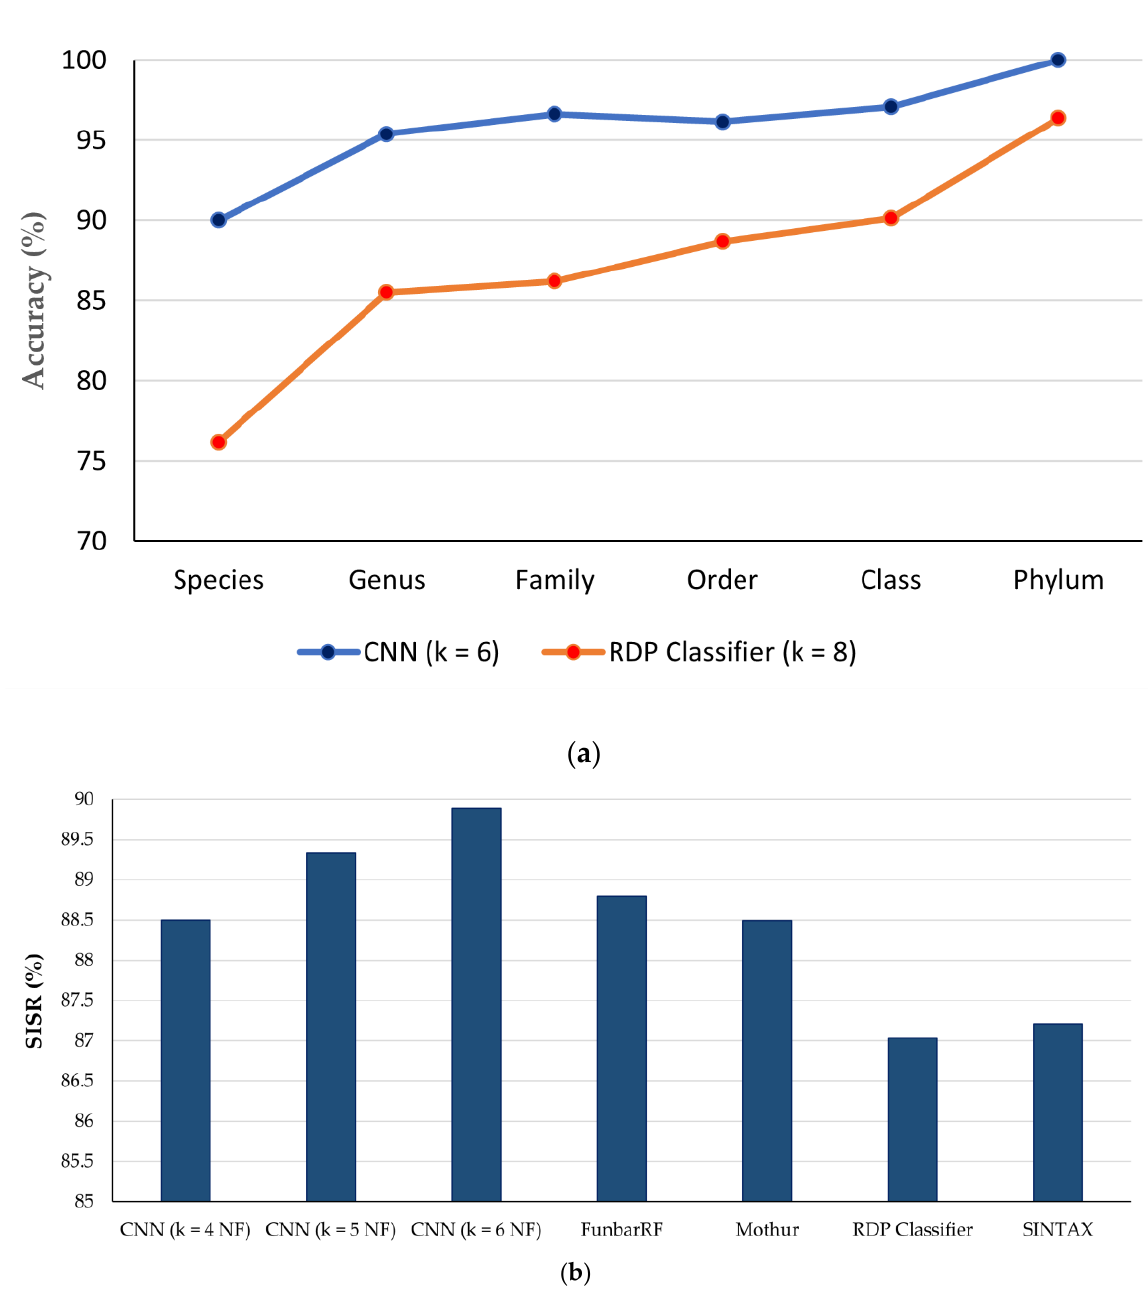
(SISR) (Table 10; Figure 8b). The scores of the performance matrices for the existing four software are obtained from the above-mentioned paper.